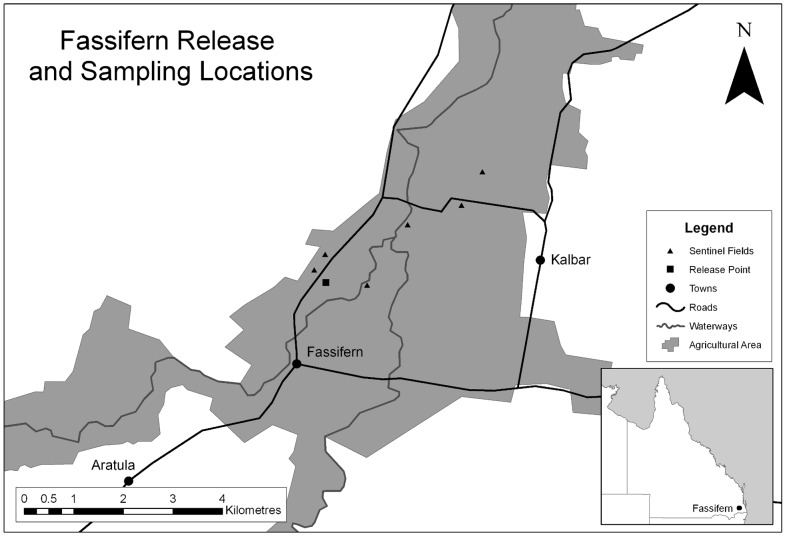
The ‘Kalbar’ site is situated in south-eastern Queensland, Australia, near the township of Kalbar and Fassifern.The sentinel collection fields were located at increasing distances from the release field in a north-easterly direction. There were no other sentinel fields within 5 kms of the release field.